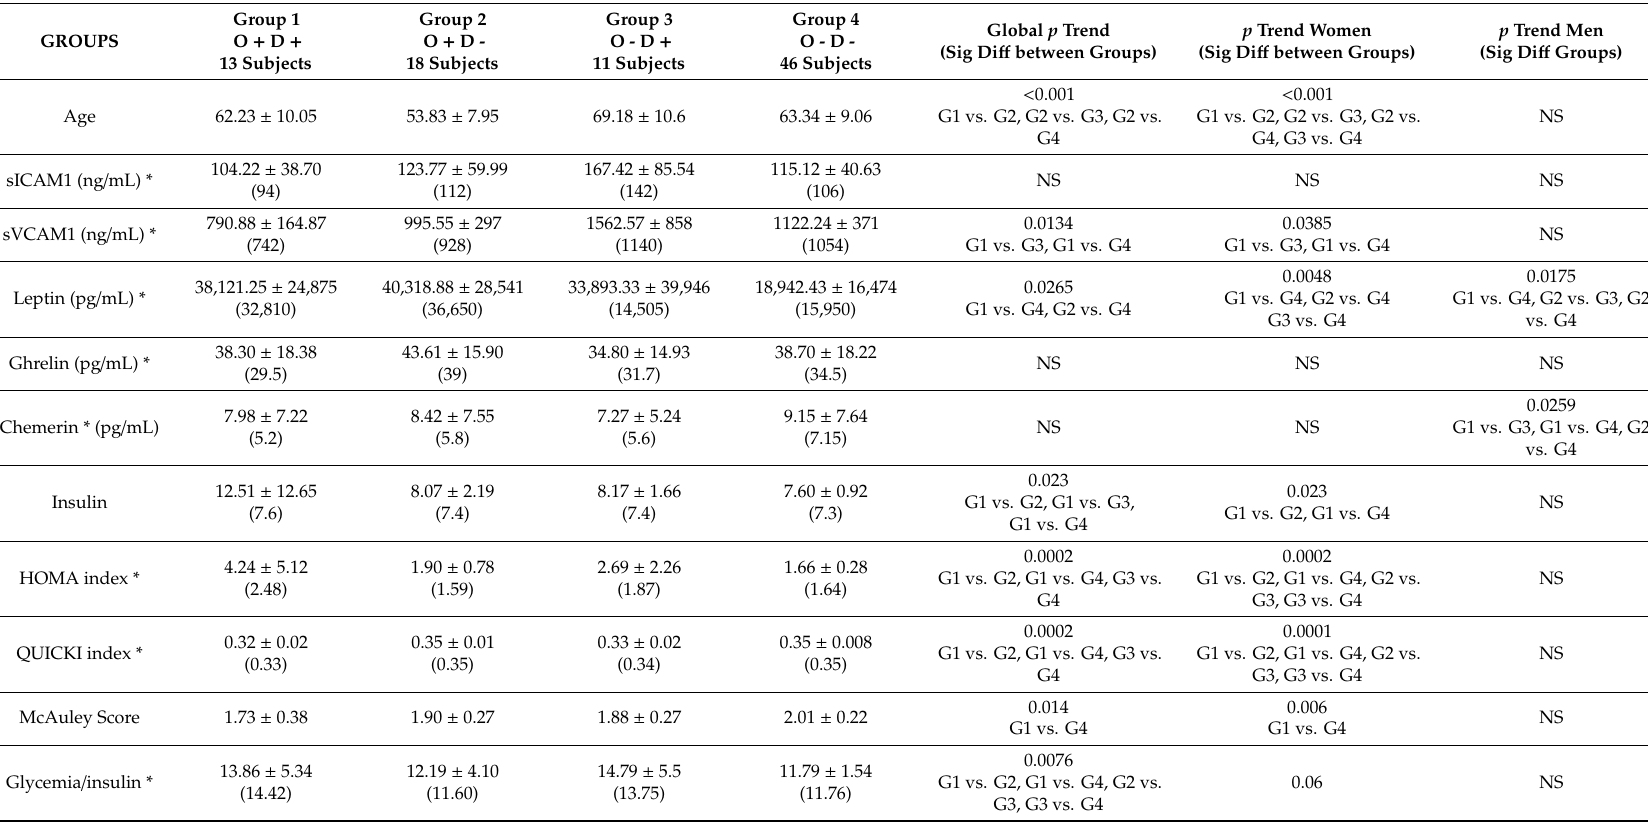
Table 3. Di ff erences between the groups regarding the di ff erent parameters (adipokines, adhesion molecules, insulin resistance